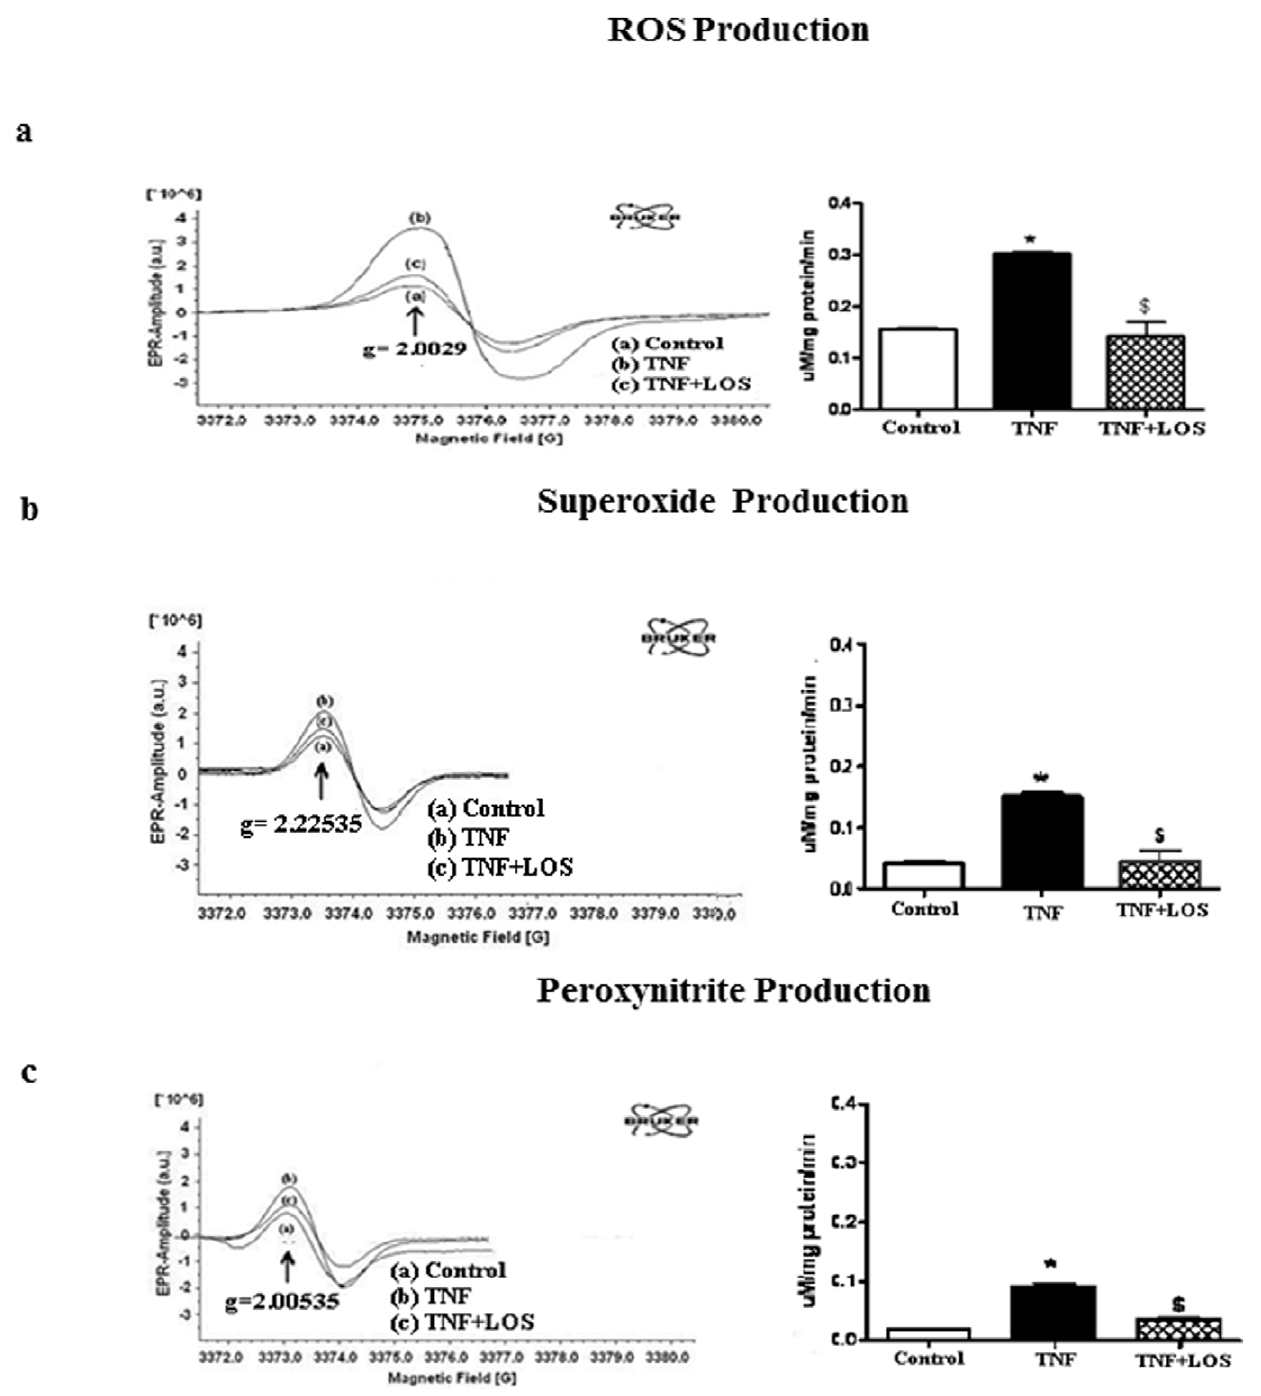
Figure 1. EPR spectra and their graphic interpretations are given. TNF administration significantly increased free radical production in LV tissue. Cytosolic a) total ROS, b) superoxide, and c) peroxynitrite production rates in rat cardiac tissues from each experimental group as measured by electron paramagnetic resonance spectroscopy. Administration of TNF to rats significantly increased production of all reactive species measured; LOS attenuated these increases. These results suggest that in the presence of an AT-1R antagonist, TNF cannot exert some of its detrimental effects.* p , 0.05 vs. control; $ p , 0.05 vs.TNF. doi:10.1371/journal.pone.0046568.g001 protein expression levels of TNF, iNOS, and eNOS were Gene and Protein Expression measured by western blotting. TNF treatment resulted in Gene expression levels of TNF, iNOS, eNOS, AT1R and significant increases in TNF and iNOS and a decrease in eNOS gp91phox were measured in the LV of rats by RT-PCR and mRNA expression vs. controls, which was significantly attenuated